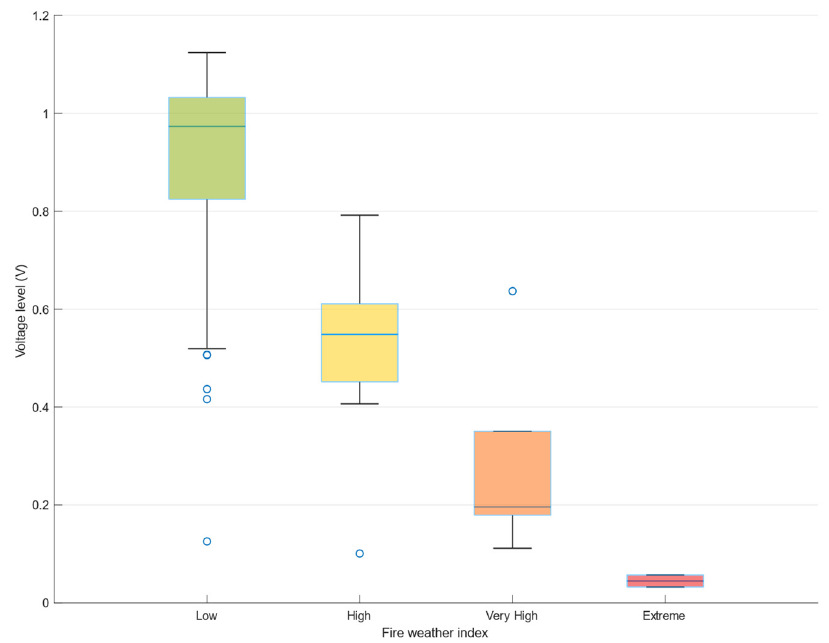
Figure 10. Voltage values for all measured days from May 2018 to October 2021 classified by FWI categories (low, high, very high and extreme wildfire risk).